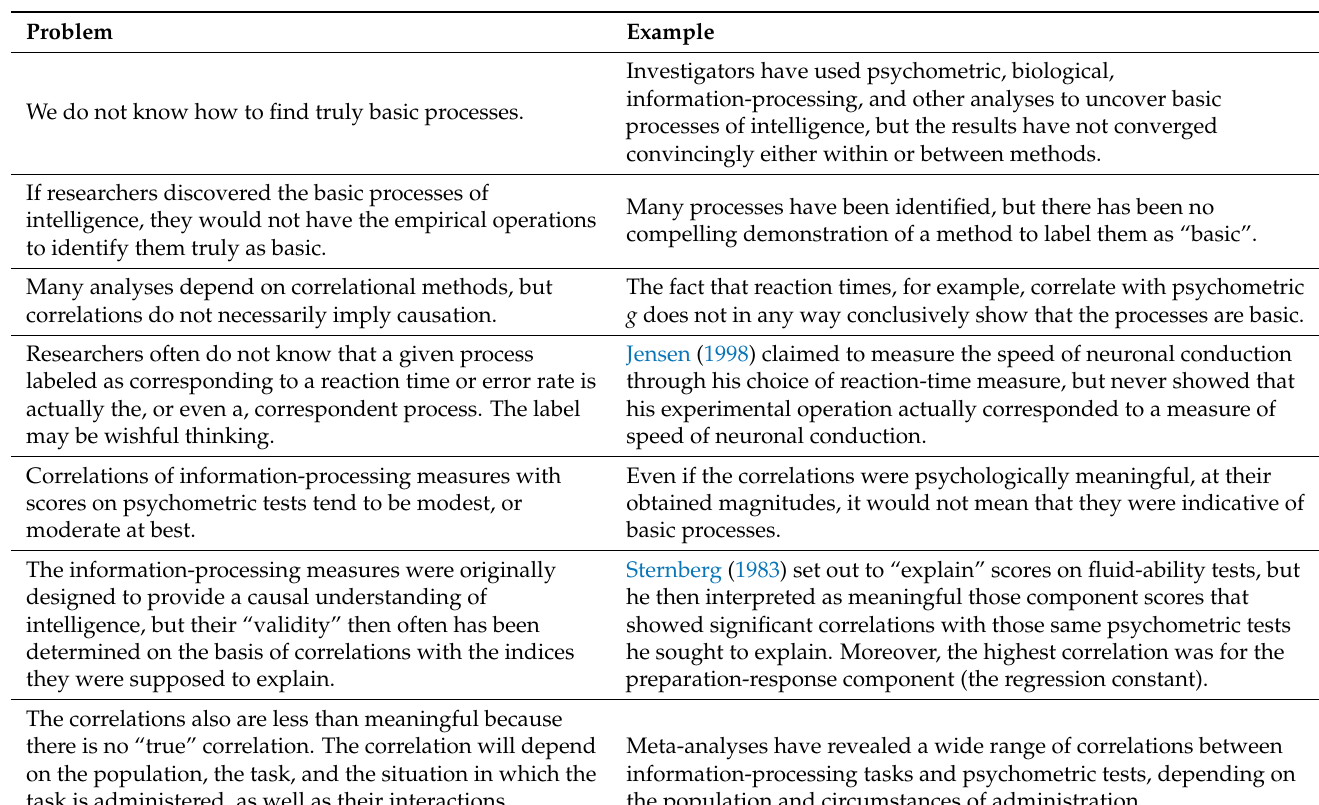
Table 1. Why and how the search for basic processes of intelligence has not